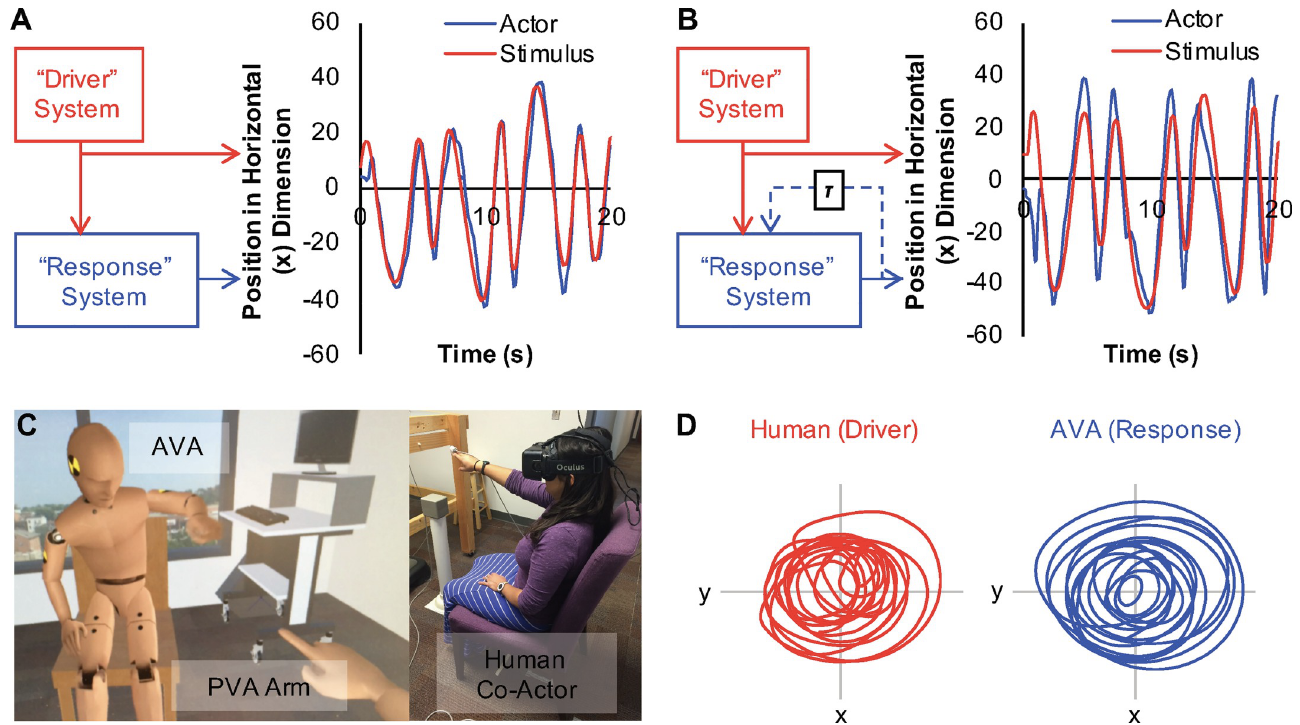
Fig 1. Coupled response-driver systems. Response-driver coupling is depicted schematically (A), along with time series from one dimension of coordinated stimulus (red) and participant (blue) movements (B) (adapted from [10] and previously demonstrated in [9]). Examples of (A) non-anticipation and (B) anticipatory synchronization are provided. The example of non-anticipation comes from a trial in which the participant experienced no feedback delay, and the example of anticipatory synchronization from a trial in which the participant experienced a 400 ms visual-motor feedback delay. Similar results were observed during interpersonal interaction with a weak bi-directional coupling between individuals. (C) The participant’s view within the virtual environment (left) and the general experimental set-up for the current study (right). (D) Typical movement time series for the AVA (left) and human co-actor (right) from AVA testing trials; i.e., human acting as driver and AVA as the response